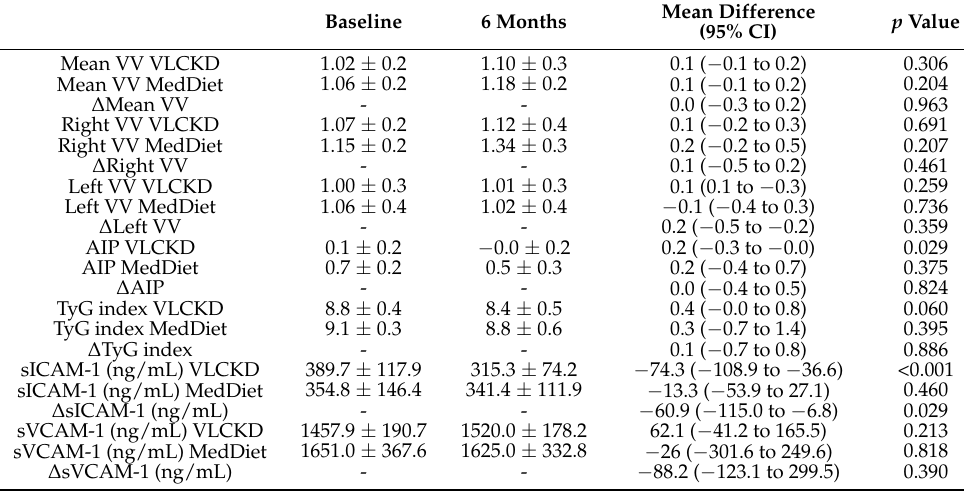
Table 3. Changes in adventitial vasa vasorum density and parameters related to endothelial dysfunc- tion between baseline and the 6-month follow-up, according to treatment group, and an analysis of the treatment